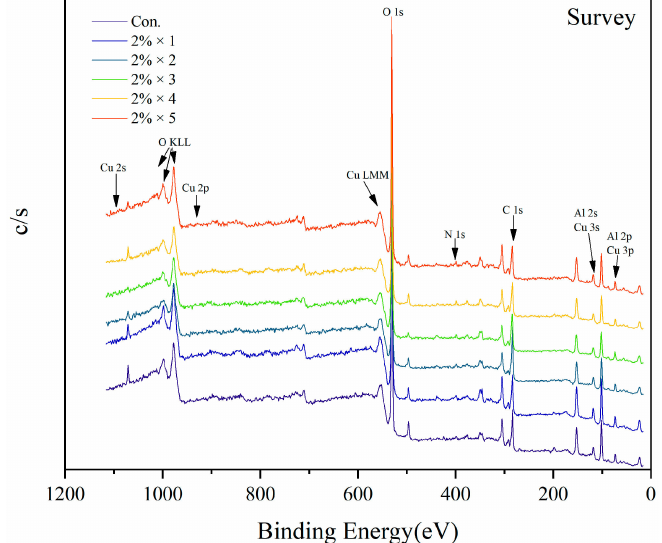
Figure 12. The XPS spectra of saline–alkali soils (Con.) and application of 2% biogas residue for one season (2% × 1), two seasons (2% × 2), three seasons (2% × 3), four seasons (2% × 4), five seasons (2% ×